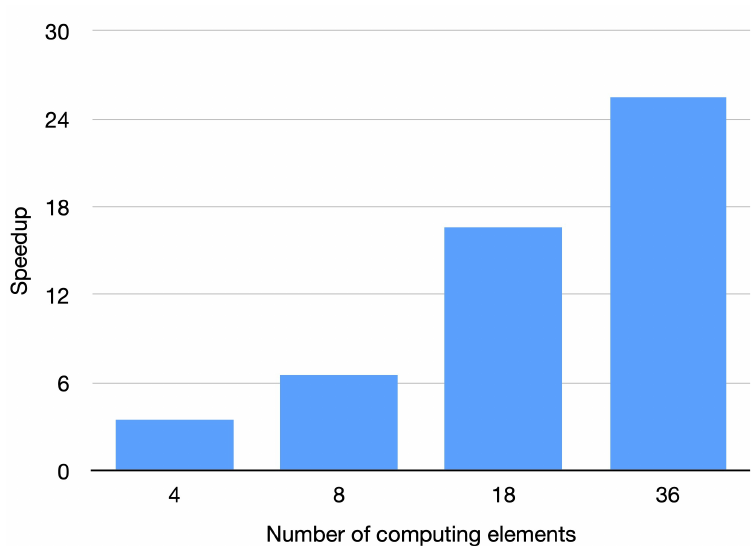
Figure 14. Speed-up for parallel implementation. Sagittal view corrupted with σ = 30, p = 0.3. Table 6. Computational